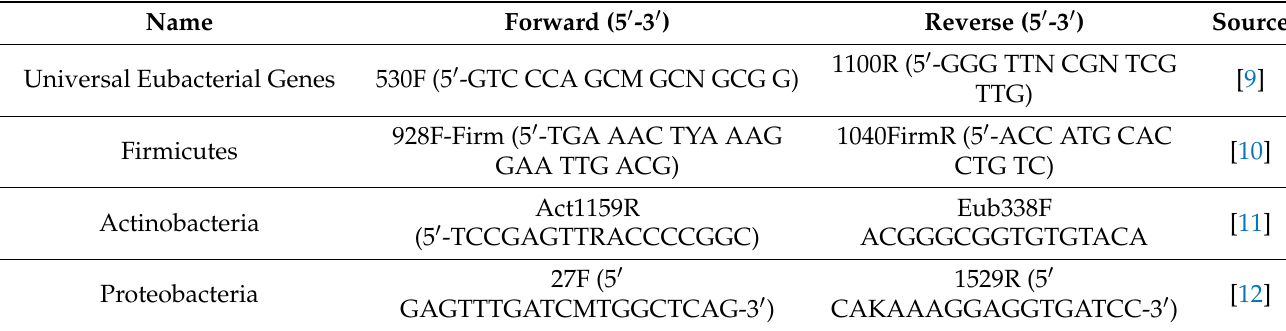
Table 2. Primers used in RT PCR